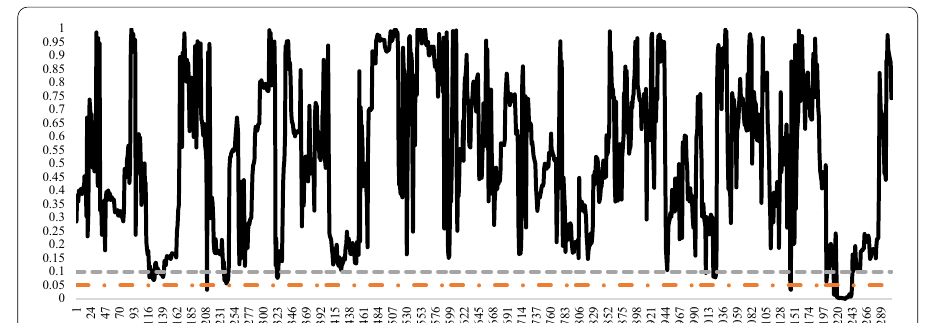
Fig. 5 The evolving p values of AQ test statistic checked for the Bitcoin (BTC) in 50-day window length